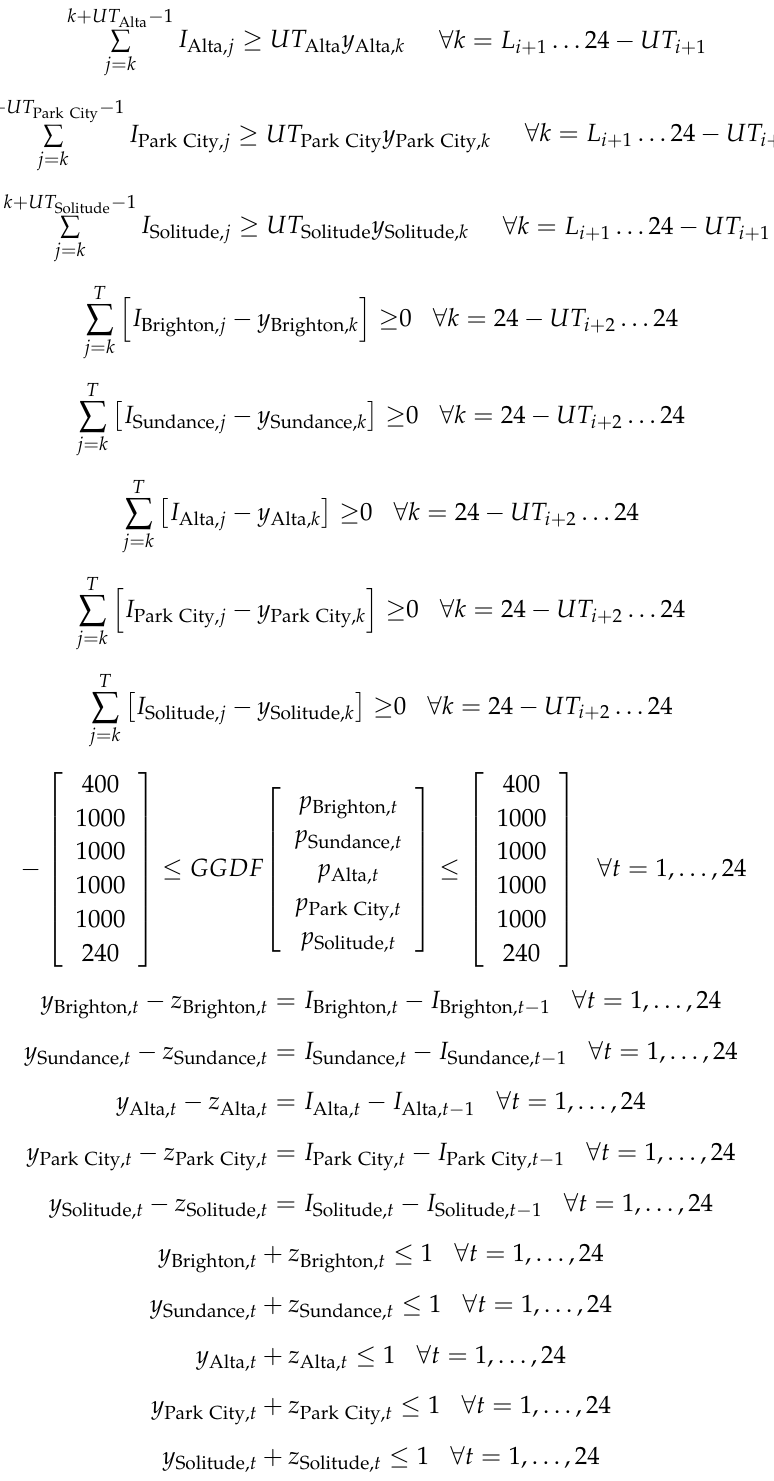
Unit commitment